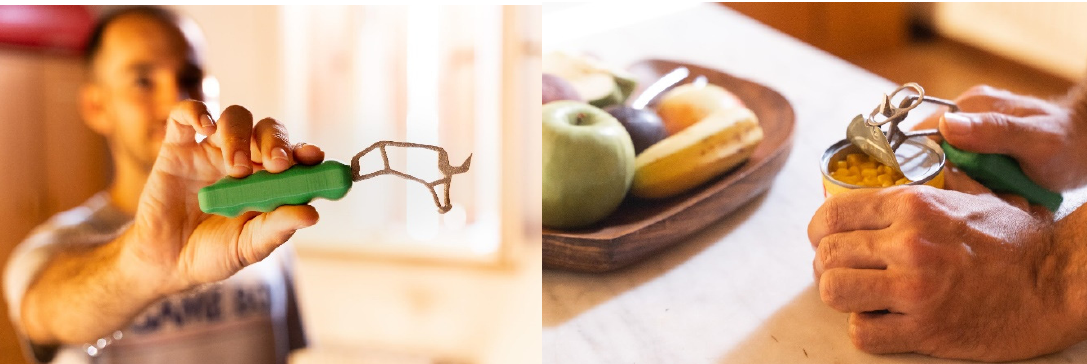
Figure 14. Optimised assistive device testing.